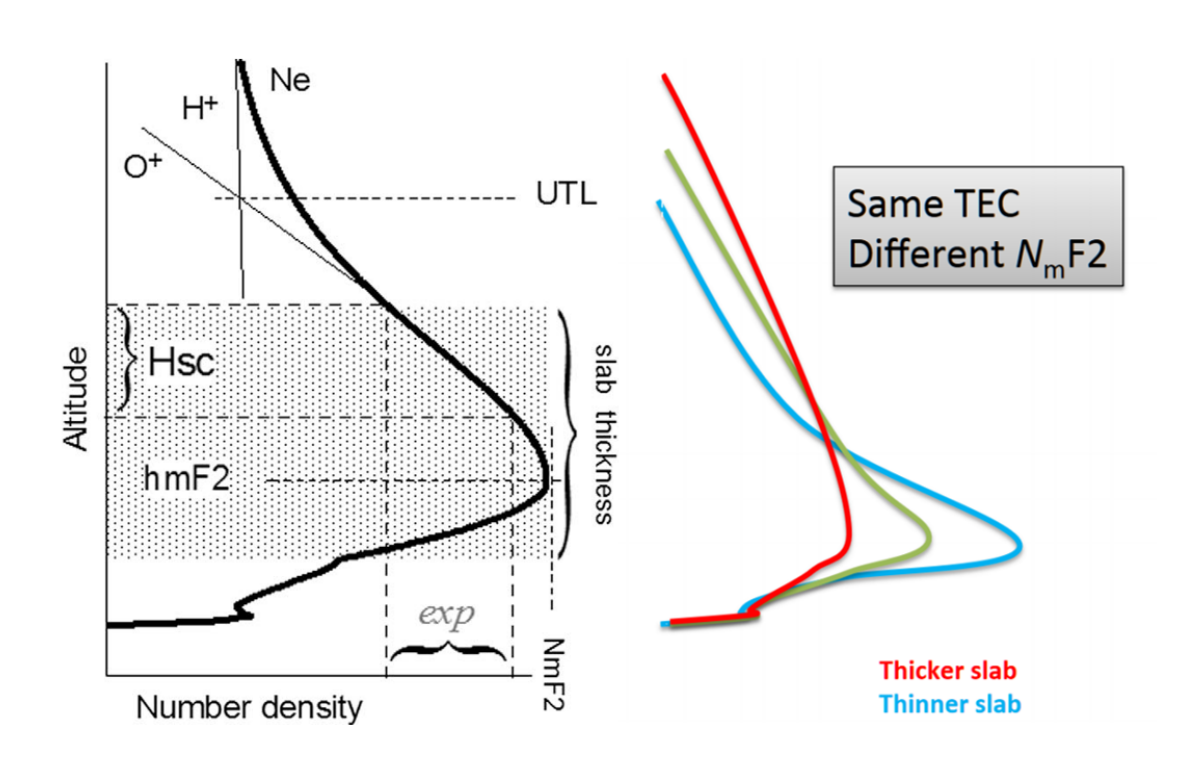
Figure 5. The left panel: schematic view of the vertical electron density profile with key characteristics such as the peak density (NmF2), peak height (hmF2), upper ion transition level (UTL), scale height (Hsc) and slab thickness τ [60]. The right panel: idealized illustration of different ionospheric profile shapes of the same VTEC and different NmF2 (not based on actual observations, hence